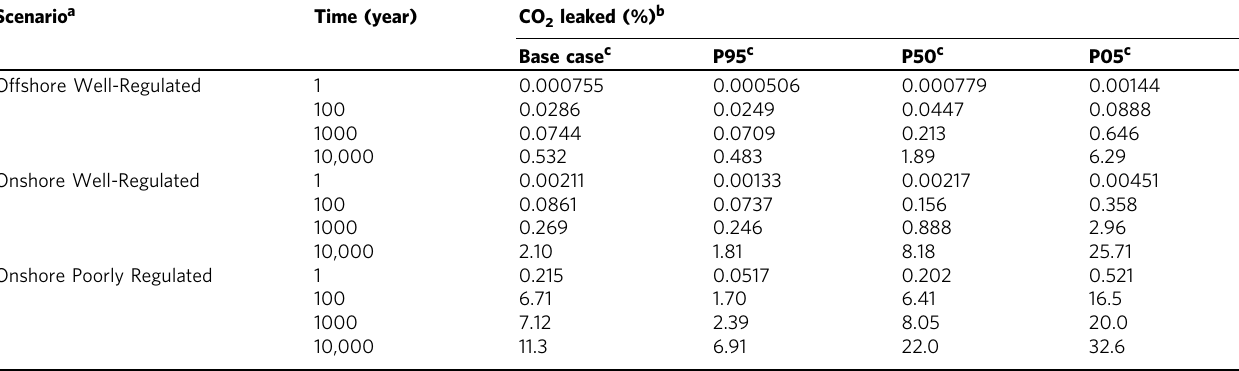
Table 1 Storage security calculator outputs Scenario